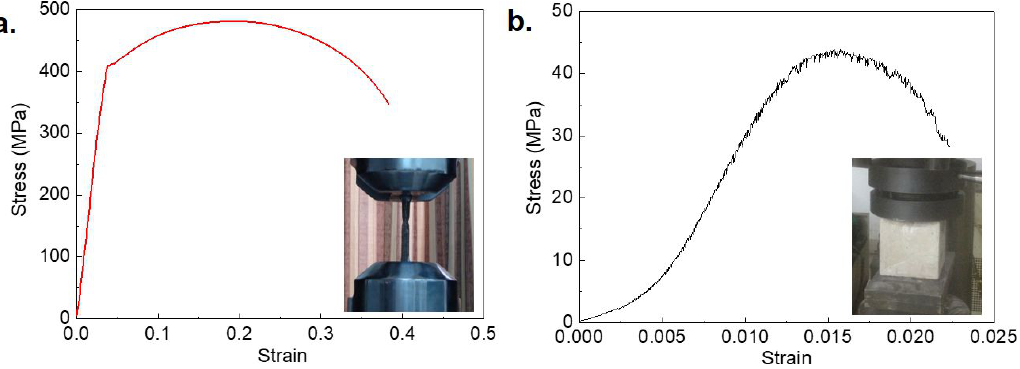
Figure 3: Typical results of the strength tests of a steel tube sample and standard concrete